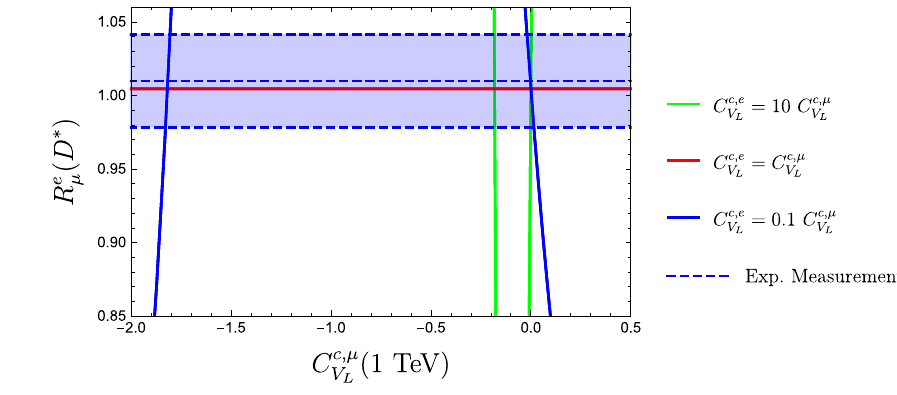
,μ and C c ,τ in different scenarios correlating C c , e V L V L